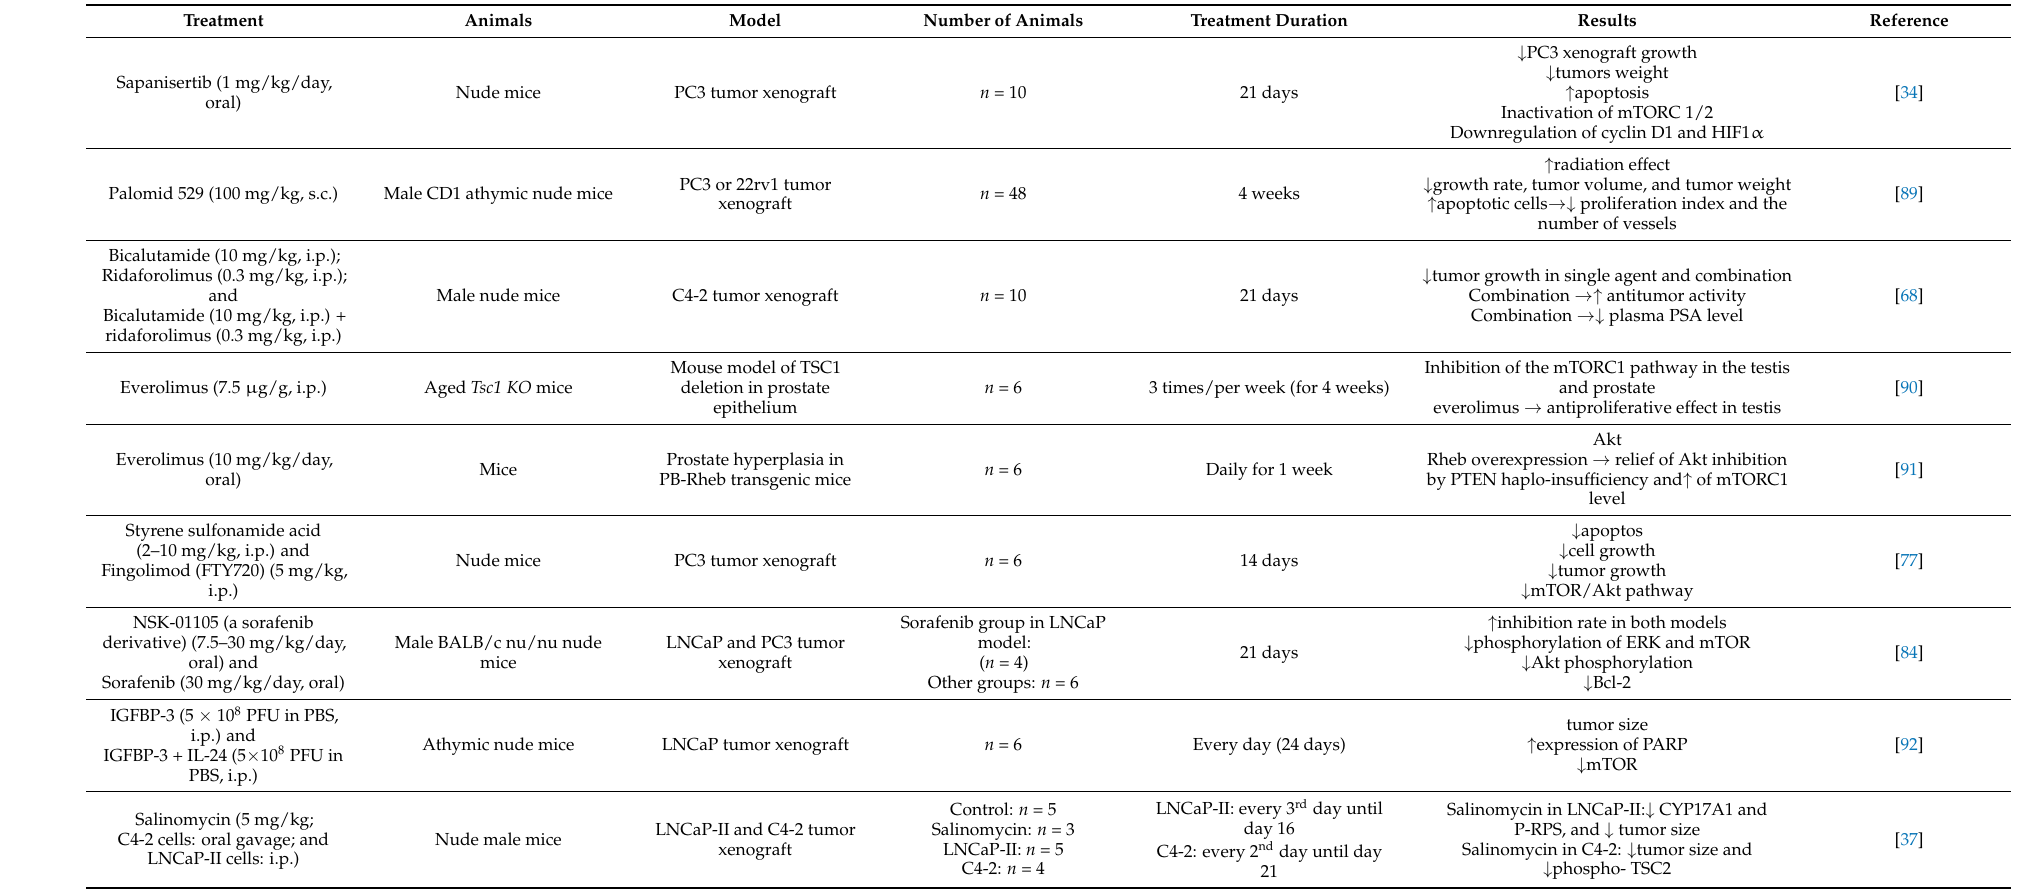
Table 2. In vivo studies on synthetic PI3K/Akt/mTOR inhibitors in prostate